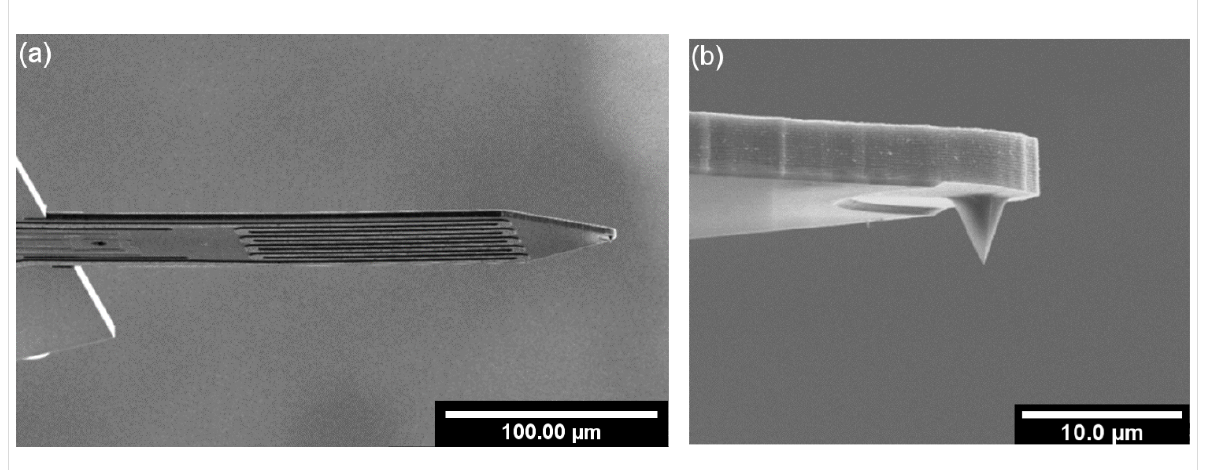
Figure 15: (a) SEM image of self-sensing and self-actuated cantilever with the thermomechanical actuator and piezoresistive deflection read-out. (b) Close-up SEM image of the tip at the front of the cantilever. Reproduced with permission through Creative Commons Attribution (CC BY)